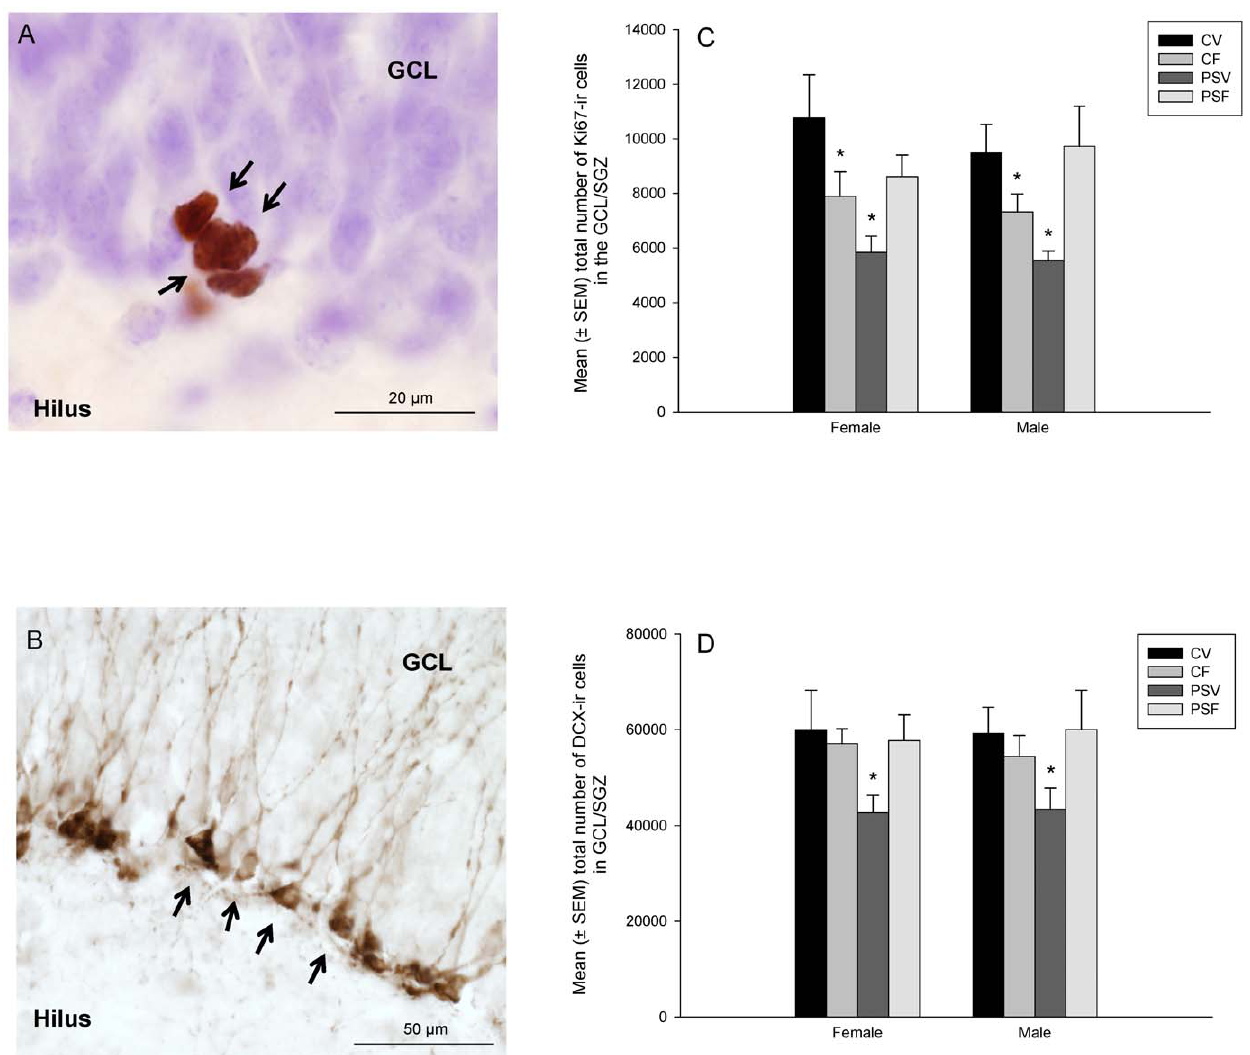
Figure 2. Photomicrographs of representative A) Ki67-ir cells and B) DCX-ir cells in the GCL/SGZ and mean ( ± SEM) number of C) Ki67-ir cells and D) DCX-ir cells in the GCL/SGZ. C) PSV adolescent offspring had significantly fewer Ki-67-ir cells in the GCL/SVZ compared to all other groups (.0001 # p # .01). CF adolescent offspring had significantly more Ki67-ir cells in the GCL/SVZ compared to PSV offspring (p # .0001), but significantly fewer Ki67-ir cells in the GCL/SVZ compared to CV and PSF offspring (.002 # p # .04), regardless of sex. D) PSV adolescent offspring had significantly fewer number of DCX-ir cells in the GCL/SGZ of the hippocampus compared to all other groups (.006 # p # .03), regardless of sex. ‘*’denotes significantly different from all other groups.